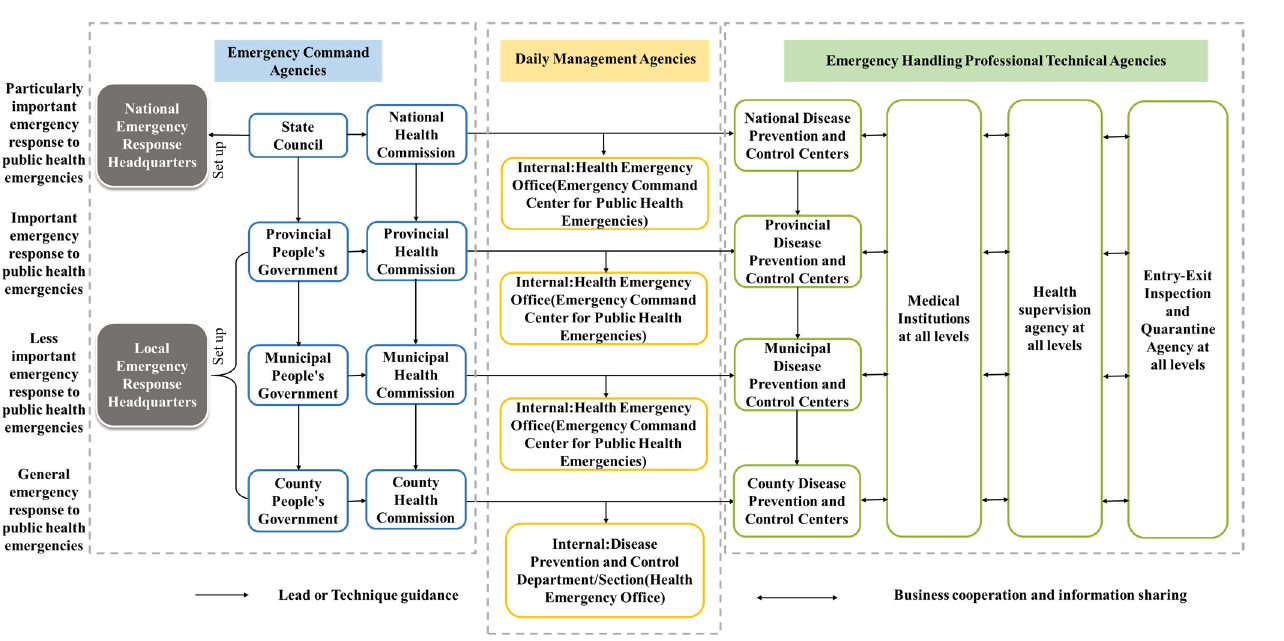
Figure 2. China’s emergency management system.